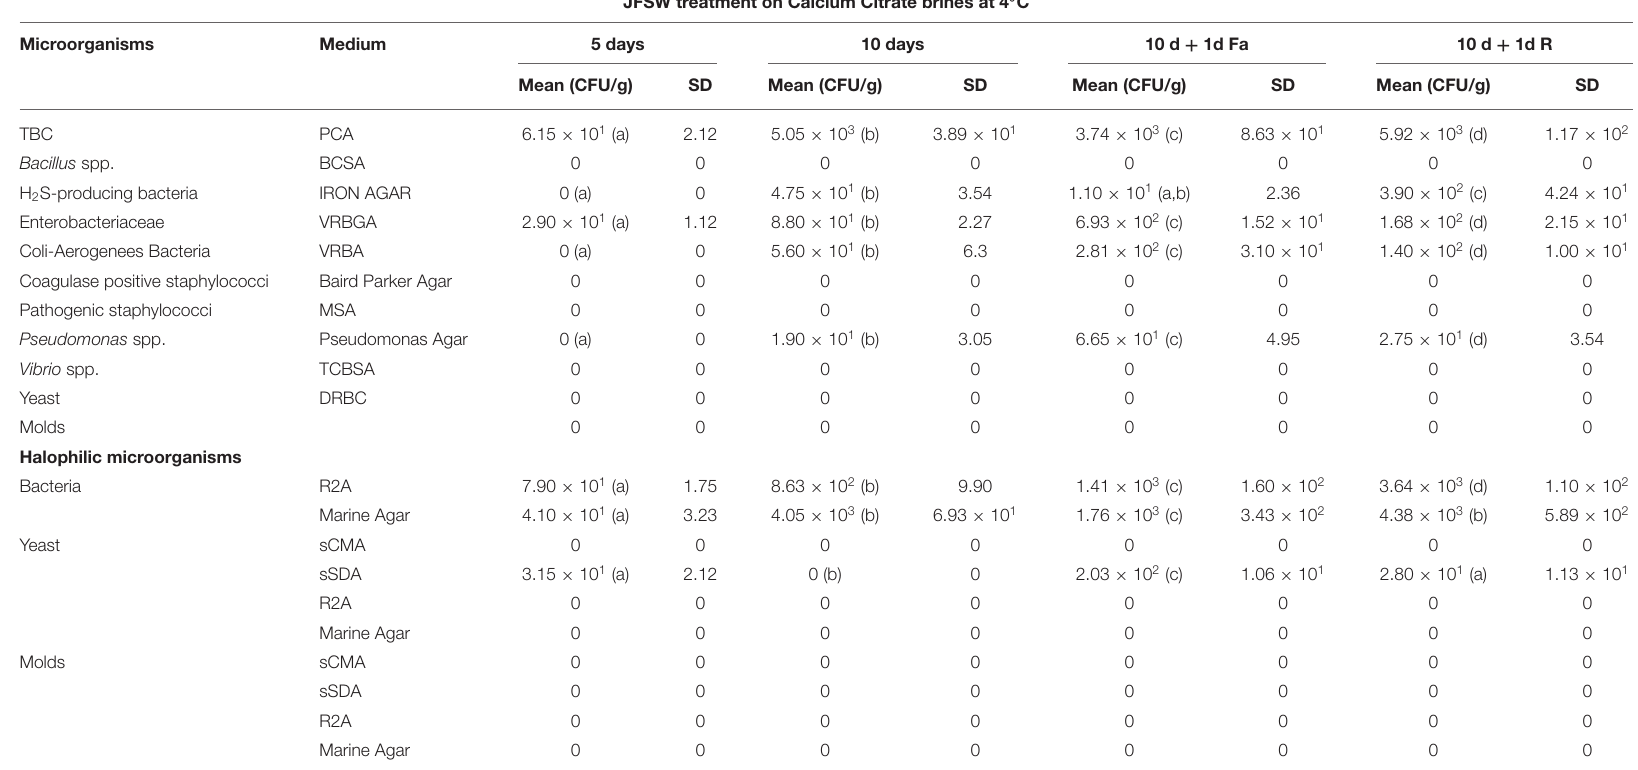
TABLE 2B | Microbiological analyses during time course treatment of JFSW with calcium citrate brines at 1, 5, and 10